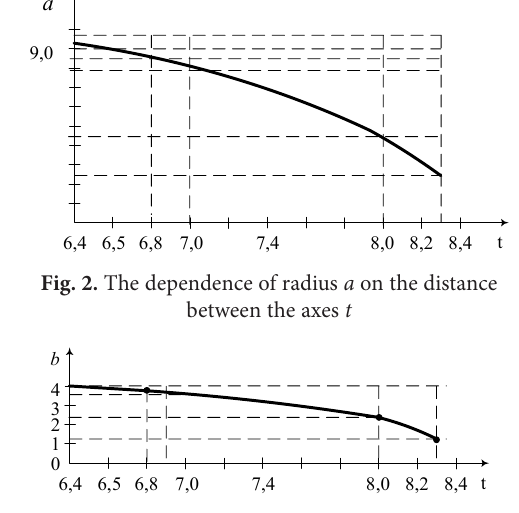
Fig. 3. The dependence of radius b on the distance between the axes t